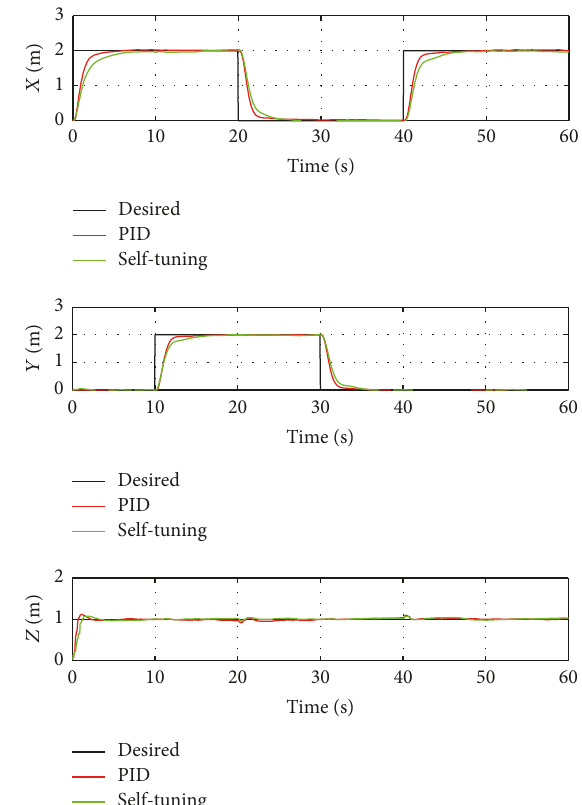
Figure 14: Response curves of quadrotor UAV position (𝑥,𝑦,𝑧) .